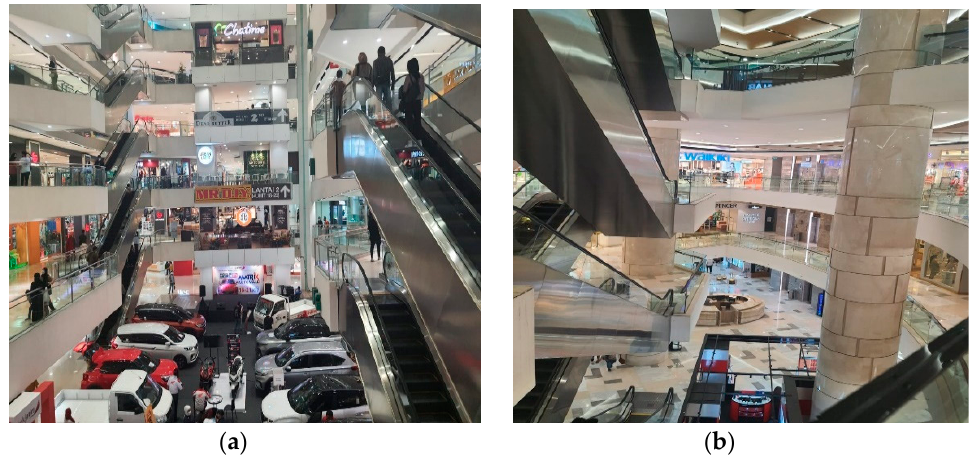
Figure 6. Comparison of shopping center GM 1 ( a ) and GM 3 ( b ).